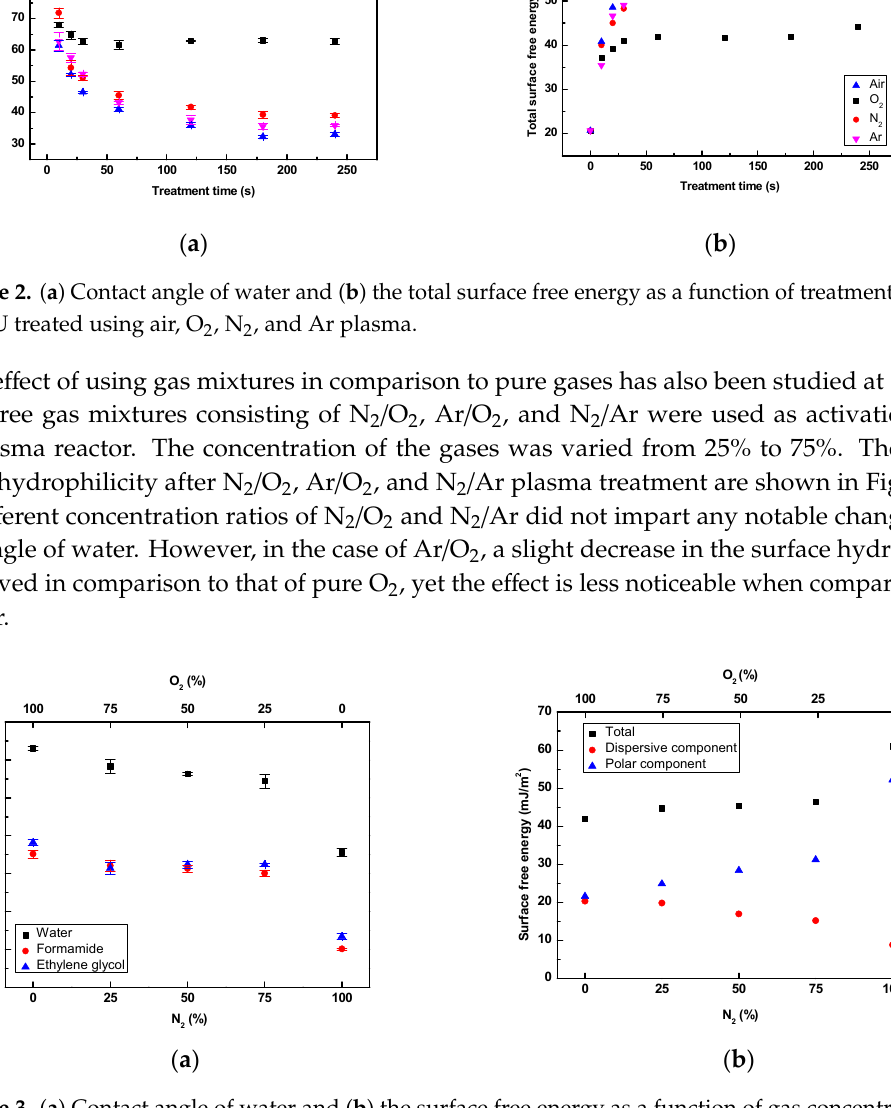
( b ) Figure 4. ( a ) Contact angle and ( b ) the surface free energy as a function of gas concentration for PU treated using Ar/O 2 plasma for 180 s. 0 ( b ) Figure 5. ( a ) Contact angle of water and ( b ) the surface free energy as a function of gas concentration for PU treated using N 2 /Ar plasma for 180 s.